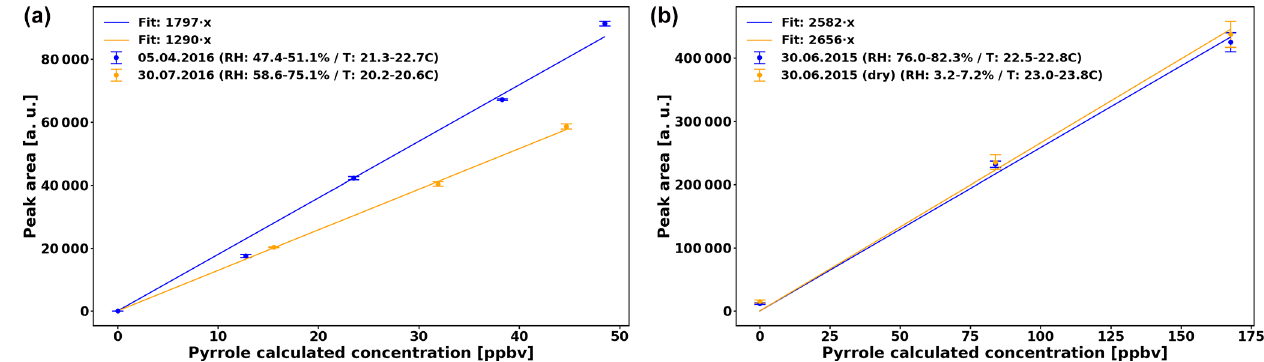
Figure 2. (a) Sensitivity of the GC–PID for pyrrole used in the present study. (b) Same day (30 June 2015) sensitivity test for sensitivity of GC–PID for pyrrole in humid and dry